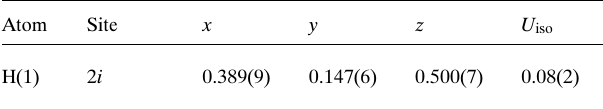
Table 2. Atomic coordinates and displacement parameters (in Å 2 )